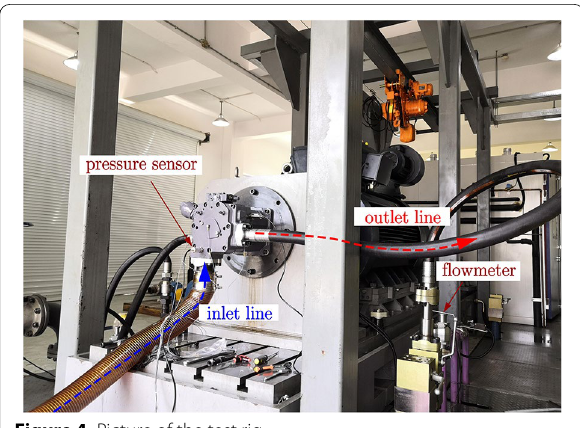
Figure 4 Picture of the test rig